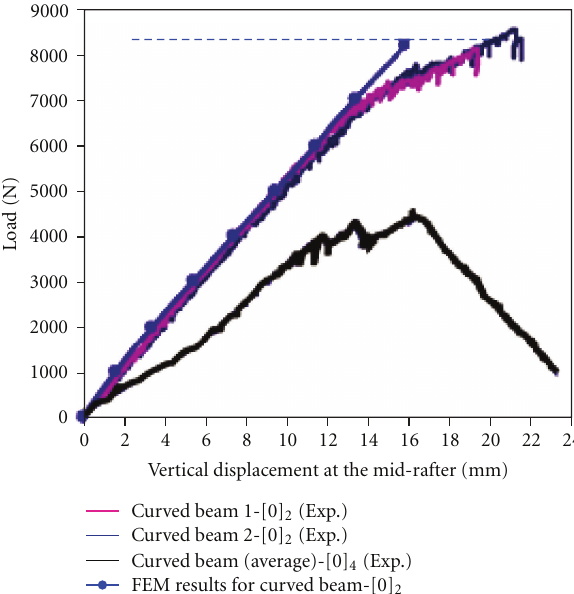
Figure 7: Load versus displacement of the three control arches and that obtained from FEA.